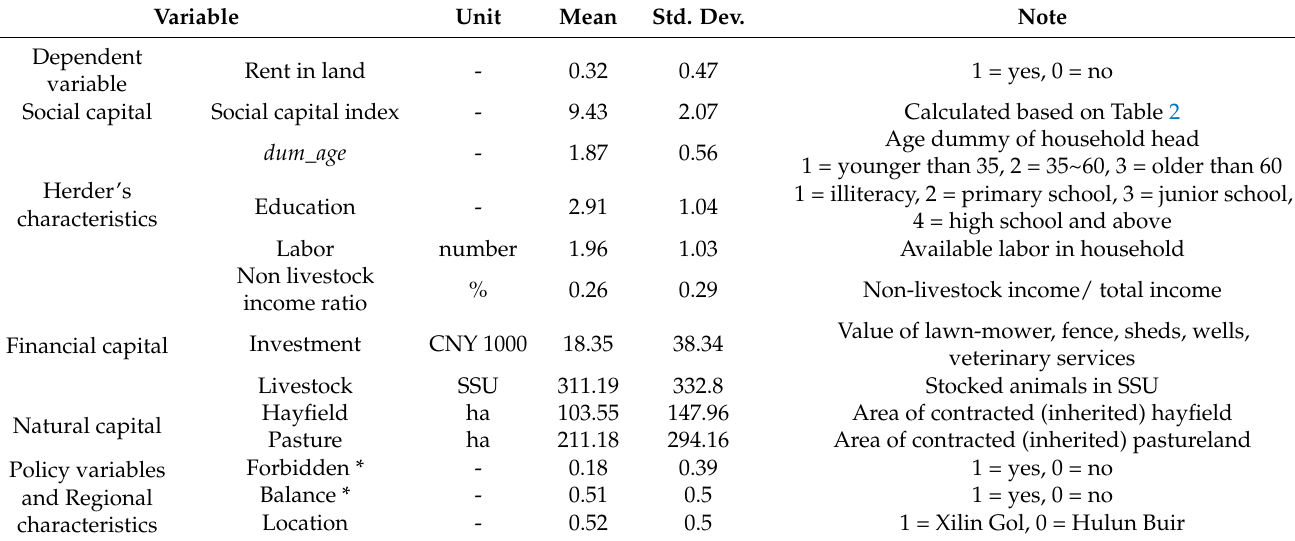
Table 3. Variable explanations and descriptive